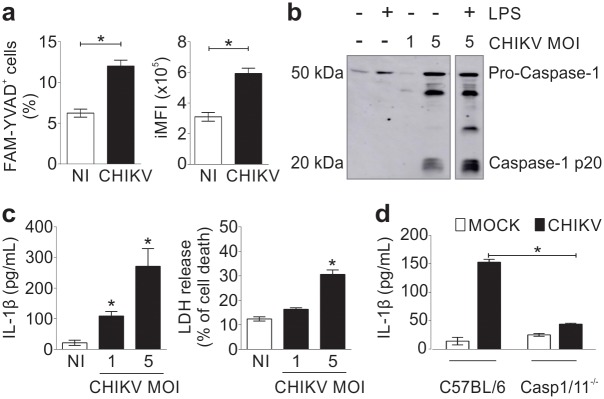
CHIKV activates inflammasome in murine macrophages.(a) Mouse bone marrow-derived macrophages (BMDMs) were infected with CHIKV with a PFU/cell of 5 or not infected (NI); after 24 hours of infection, the cells were stained for active caspase-1 with FAM-YVAD. The percentage (left) and the integrated mean of fluorescence (iMFI) of the activated cells (right) is shown. (b) After 24 hours of infection, supernatants were harvested from non-infected (NI) or CHIKV-infected BMDMs treated with LPS as depicted and levels of cleaved caspase-1 (p20) were detected by western blotting in the supernatant. (c) LPS-primed BMDMs were infected with CHIKV with a PFU/cell of one or five. After 24 hours of infection, the levels of IL-1β (left) and LDH (right) in the cell-free supernatants were measured. (d) Production of IL-1β by BMDMs from wild type (C57BL/6) or Casp1/11 deficient mice 24 hours post-CHIKV infection. Data from (a), (c) and (d) are represented as the mean ± SD of the triplicate samples and are representative of the three independent experiments that yielded similar results. Statistical analysis was performed with Student’s t-test. Asterisks indicate statistically significant differences. *P < 0.05.